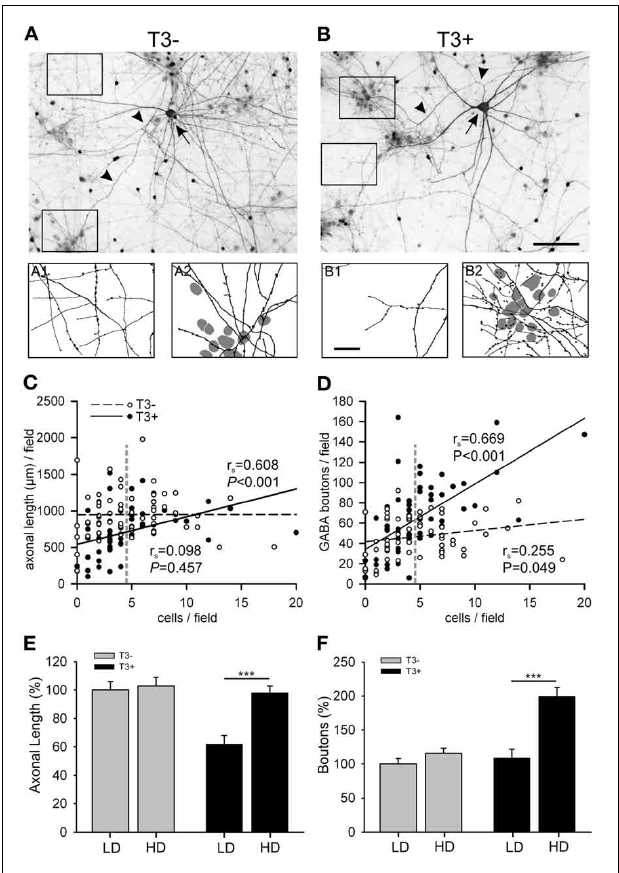
FIGURE 6 | (A,B) Images show GABA-immunostained 14-day-old cultures grown in the absence (A) or presence (B) of T3. Each image shows a L-GABAergic neuron (arrow) with its conspicuous axons (arrow heads) surrounded by smaller S-GABA neurons and unstained non-GABAergic neurons. In T3 − cultures, both cell-poor (A 1 ) and cell-rich (A 2 ) regions are equally covered with L-GABAergic axons. In T3 + cultures, L-GABA axons selectively target groups of neuronal cell bodies (B 2 ), but sparsely innervate cell-poor regions (B 1 ). The scatter plots show that the axonal length (C) and the number of GABAergic boutons (D) are positively correlated with the local density of non-GABAergic neurons in T3 + , but not in T3 − cultures. Each dot represents one field (120 × 90 μ m). Lines show best linear fit. P -values and r s coefficients are results of Spearman rank order correlation tests (SROC). Vertical dashed lines in (C,D) indicate the mean cell density of non-GABA neurons. This value was defined as the border between LD and HD fields (see text). (E,F) show means ± SEM of the data grouped according to the local cell density. LD, Low cell density fields; HD, High cell density fields; Scale bars: 100 μ m in (A,B) ; 25 μ m in A 1 ,A 2 and B 1 , B 2 .